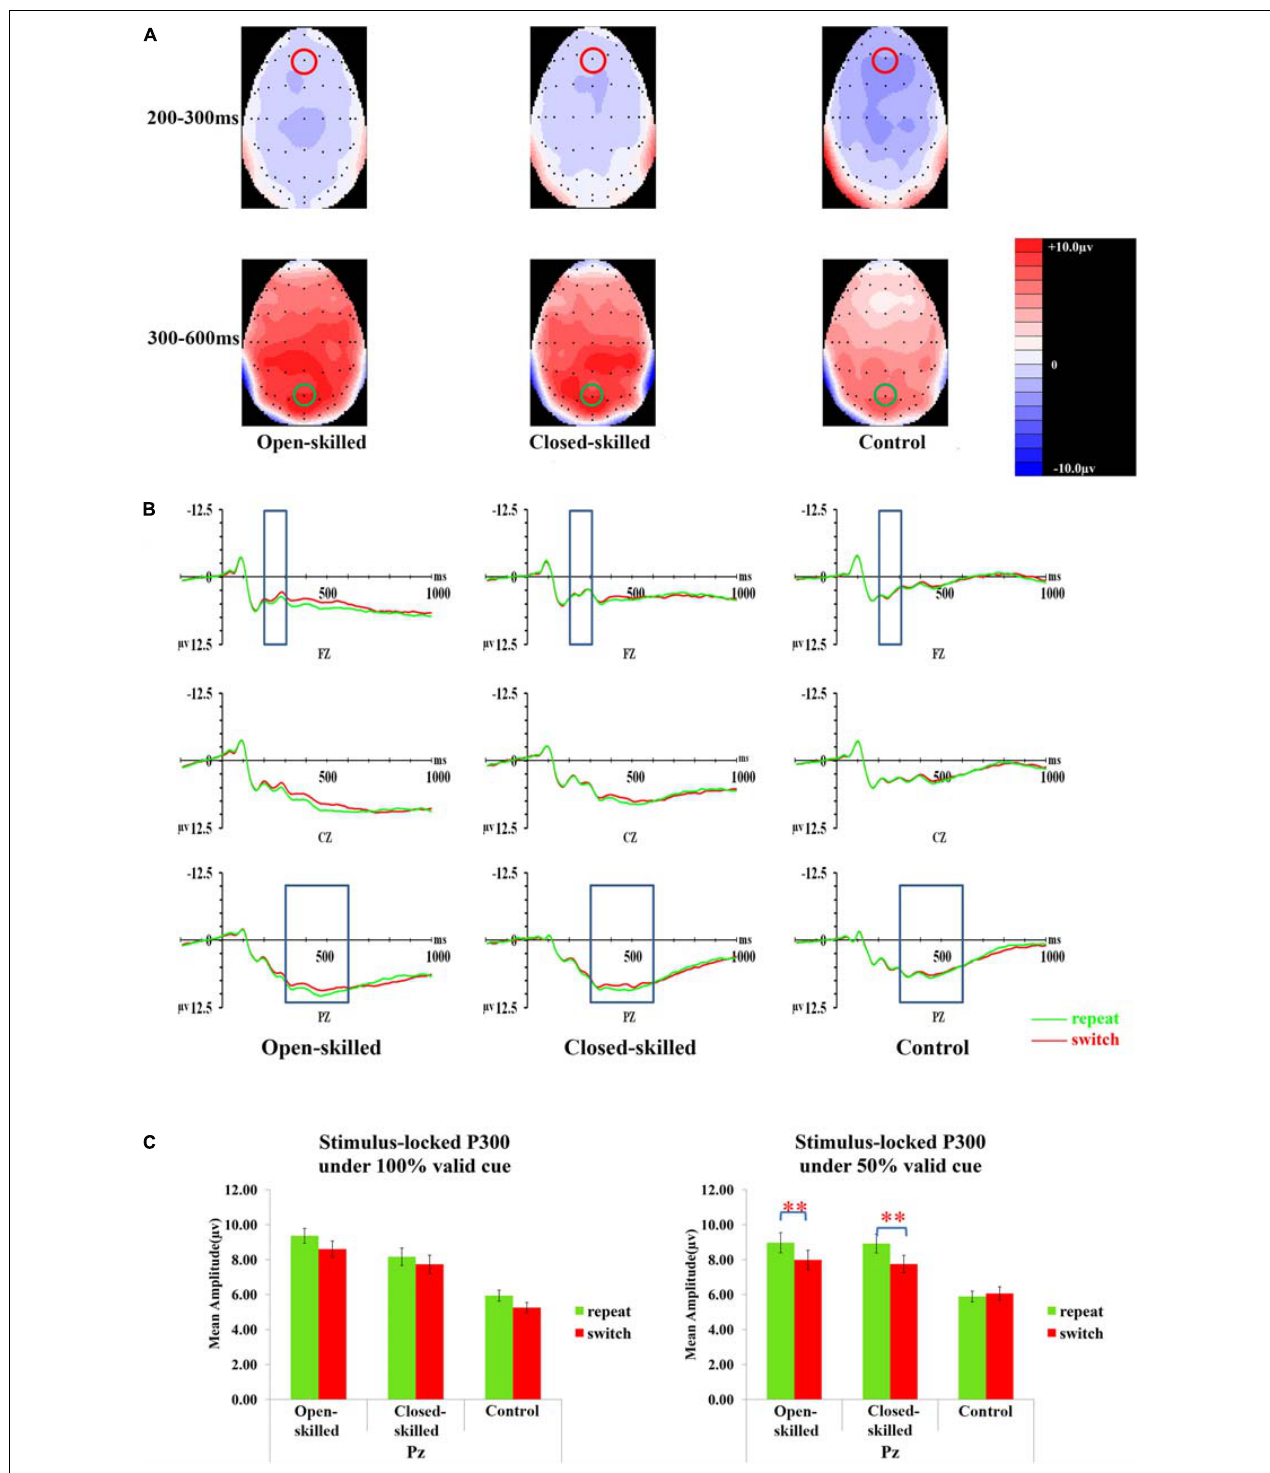
FIGURE 5 | Analyses of the N2 and stimulus-locked P3 among three groups of participants. (A) Topographical distributions of N2 (200–300 ms) and stimulus-locked P3 (300–600 ms) post-target time-window regardless of trial types and validities; the Fz site is indicated with the red circle, and the Pz site is indicated with the green circle. (B) Mean amplitudes of the waveforms of the repeat (in green) and switch (in red) trial-types regardless of validities; the 200–300 ms time-window at Fz and 300–600 ms time-window at Pz are indicated with the rectangular boxes. (C) Comparisons of the mean amplitudes between the repeat and switch trial-types at the Pz site for the 100% (left panel) and 50% (right panel) validity conditions. ∗∗ p < 0.010.